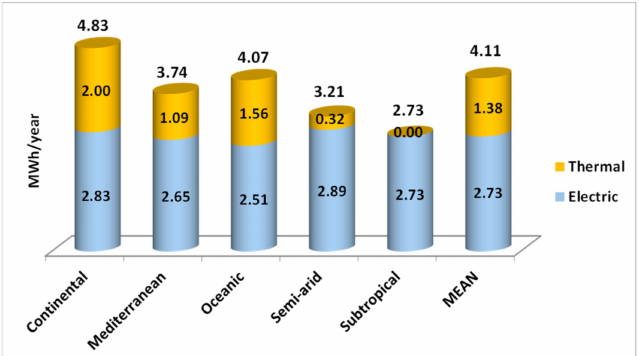
Figure 10. Thermal, electric, and total energy consumption per inhabitant of each Spanish climate zone.